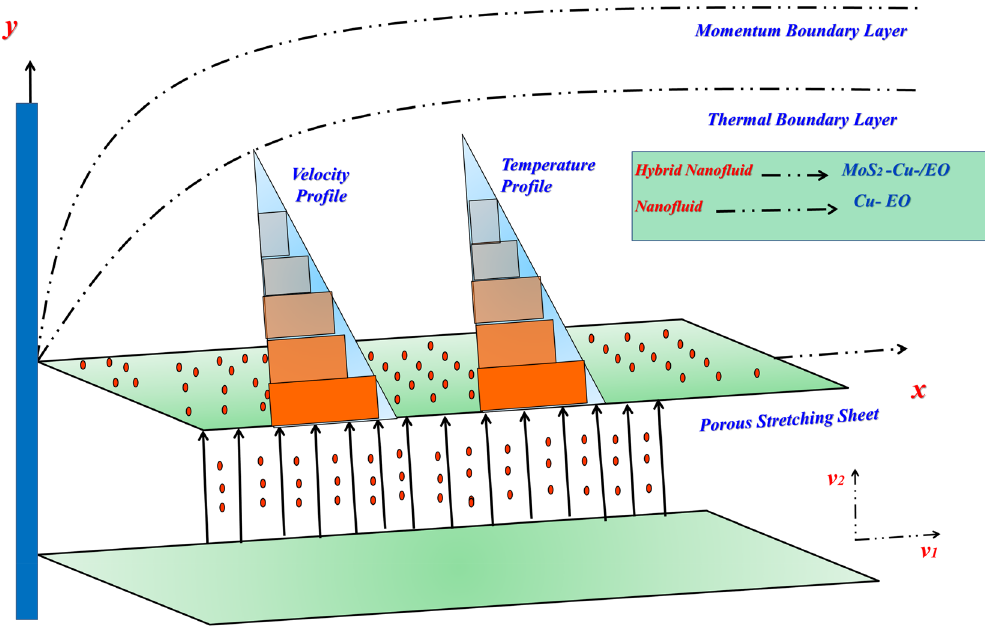
Figure 2. Diagram of the flow